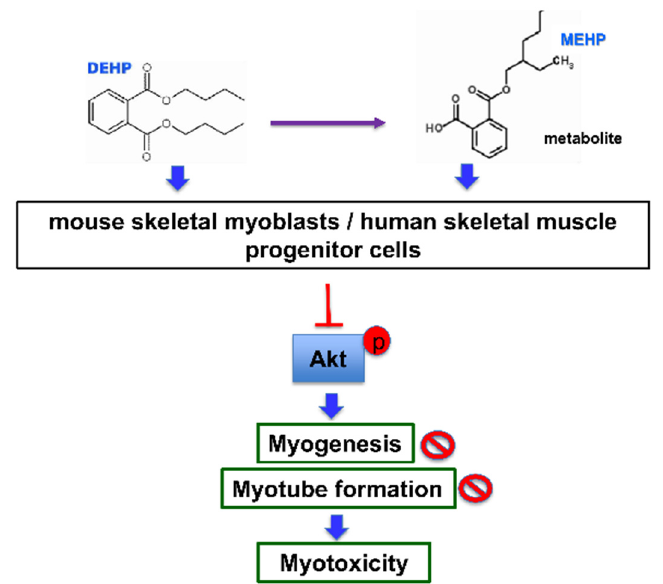
Figure 7. A schematic summary of the main findings for both DEHP- and MEHP-related cytotoxic effects on myogenesis in differentiating mouse and human skeletal muscle cell models.